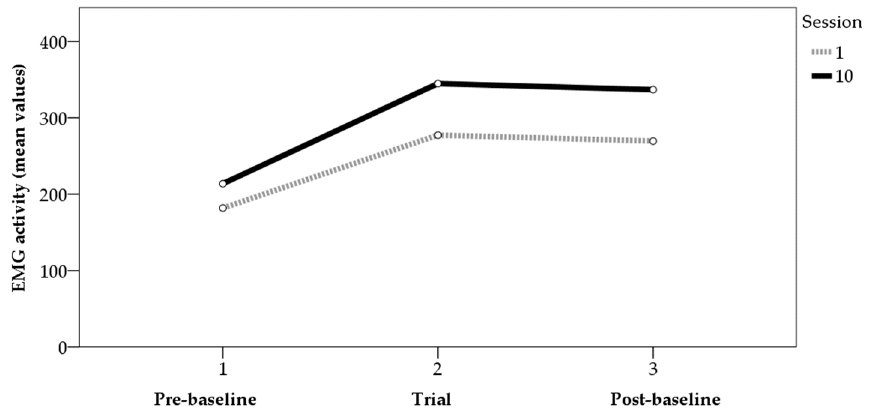
Figure 2. EMG activity (mean values) pre-baseline, trial, and post-baseline (sessions 1 and 10).